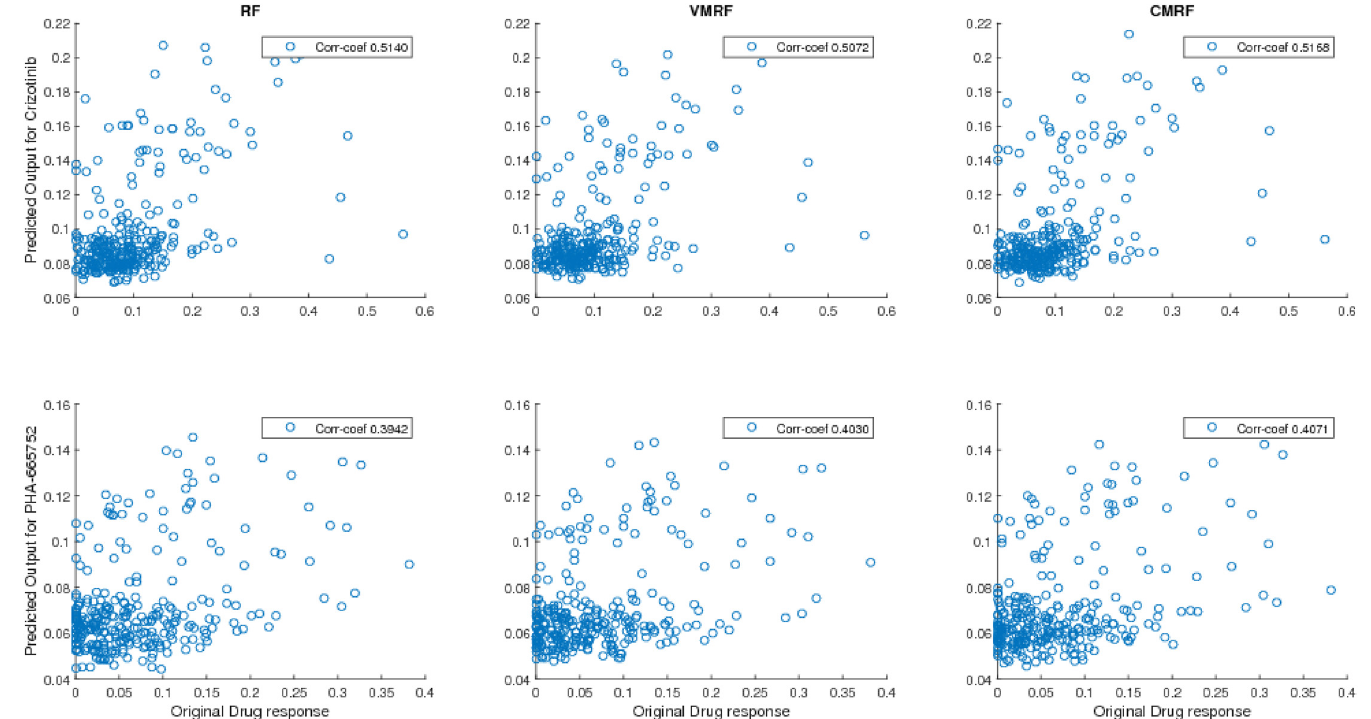
Fig 8. Scatter plots of predicted response vs original response for Crizotinib and PHA-665752 (CCLE). Here corr-coef stands for correlation coefficient between predicted response and output